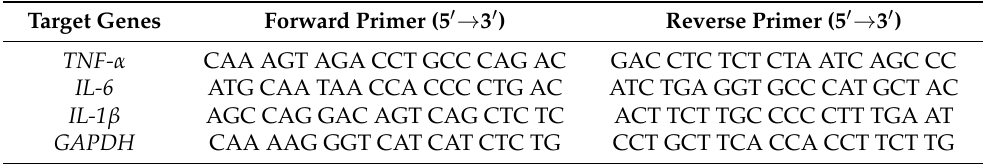
Table 1. Primer sequences for real-time